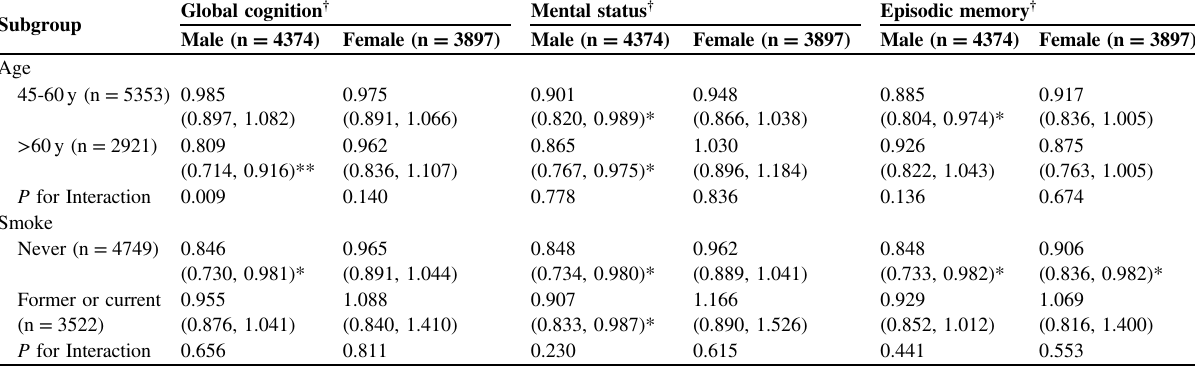
Table 4 Subgroup analysis of adjusted odds ratio of cognitive decline for PEF at baseline Subgroup